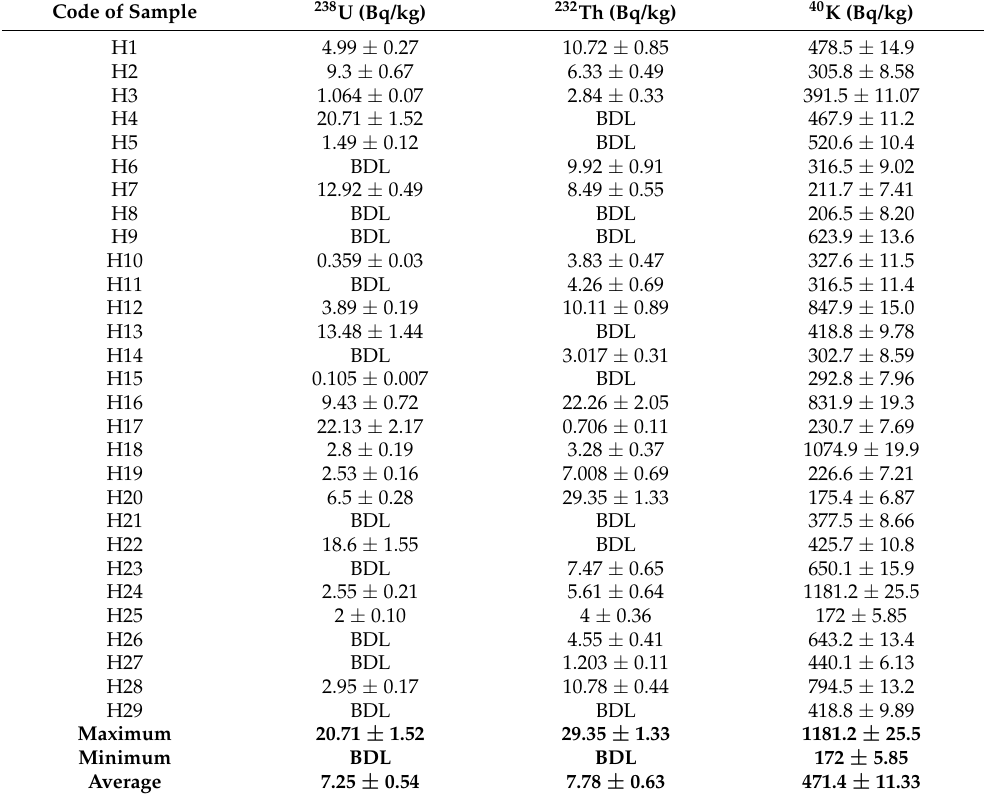
Table 2. Specific activities (Bq/kg) of 238 U ( 226 Ra), 232 Th, and 40 K in medicinal plant samples using a γ -spectrometer.